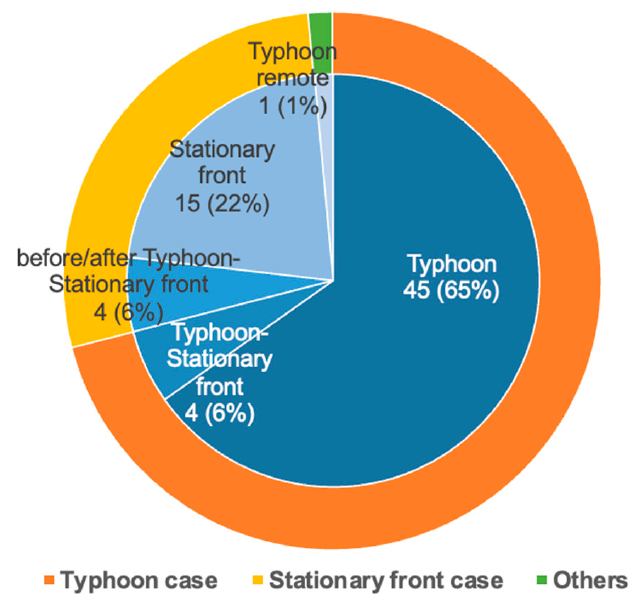
Figure 14. Number of pre-release cases by meteorological cause.